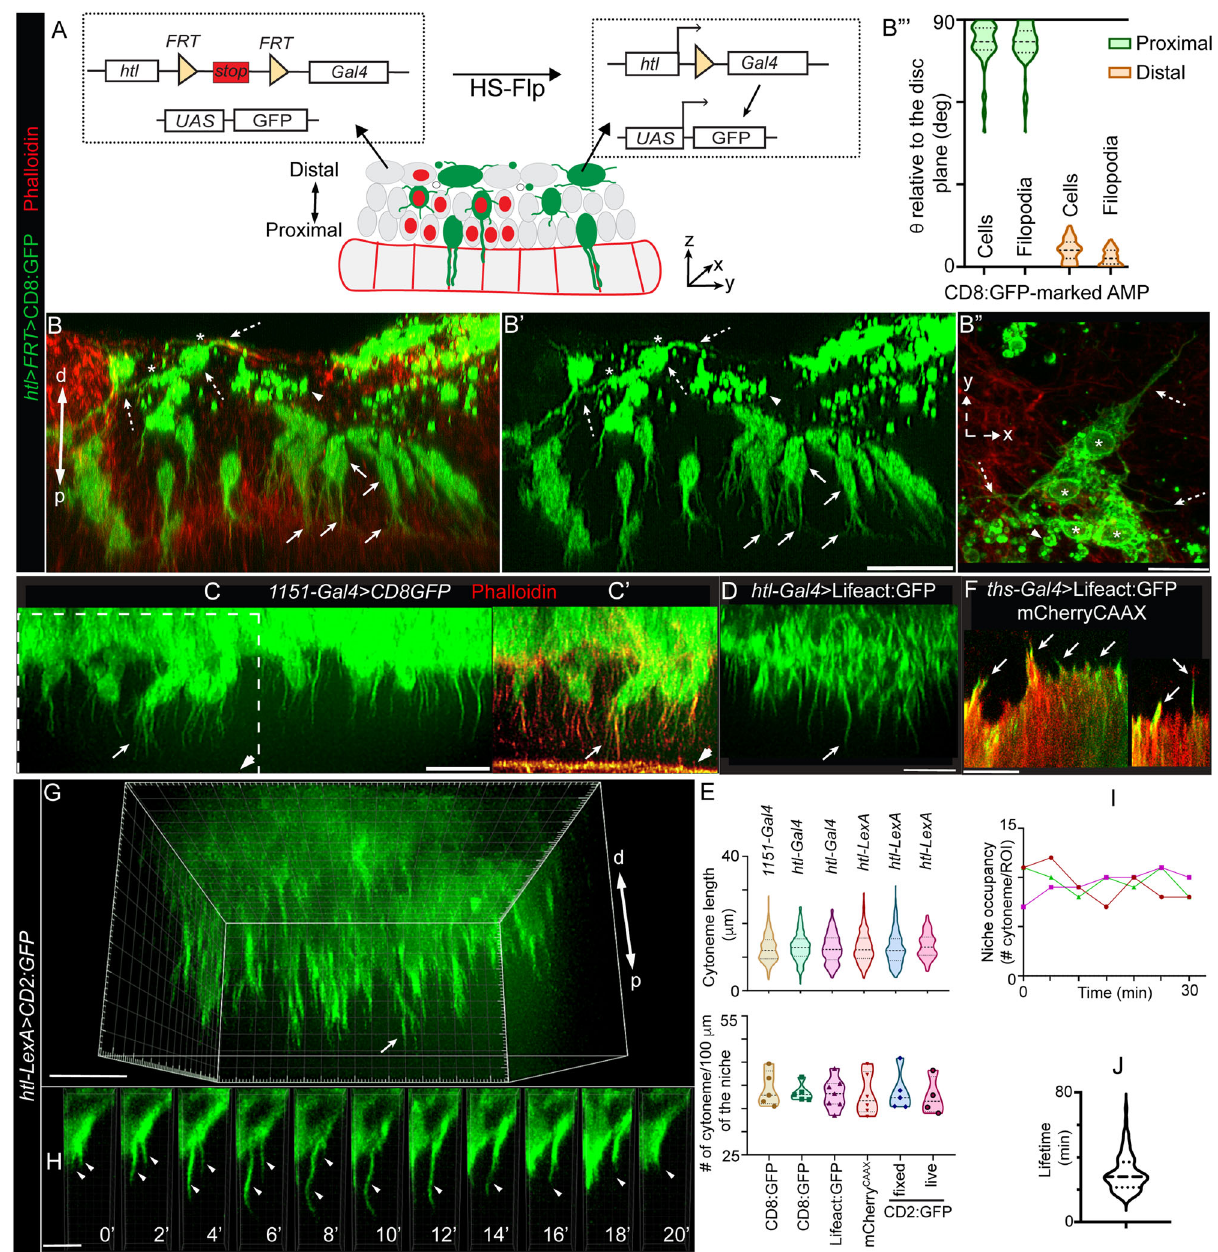
Fig. 2 Disc-speci fi c AMP polarity and adhesion are linked to polarized AMP cytonemes. A Schematic depiction of htl > FRT > stop > FRT > Gal4 construct and its application to generate FLIP-out clones exclusively in AMPs (also see Supplementary Fig. 1E, F). B - B ” Wing disc harboring random CD8:GFP-marked AMP clones ( hs-Flp; UAS-CD8:GFP; htl > FRT > stop > FRT > Gal4 ) showing orthogonal and lateral polarity of AMPs and AMP cytonemes relative to disc plane; arrow and dashed arrow, proximal and distal AMPs/AMP cytonemes, respectively; arrowhead, distal small non-polar cells; *, adherent distal AMPs; phalloidin (red), actin-rich disc-AMP junction and cell-cortex (also see Supplementary Fig. 1G – H ” ); B ’ GFP channel of B ; B ”’ Violin plots showing angles (Theta, θ ; see Fig. 1G) between proximal and distal AMPs and their cytonemes relative to their underlying disc plane (see Supplementary Table 2 for statistical analyses). C – E Comparison of AMP cytonemes (arrows) marked by various fl uorescent proteins driven by different transcription drivers, in fi xed and live tissues, as indicated; arrowhead, actin-rich (phalloidin-marked) apical-junction of disc epithelium; E Graphs comparing length and numbers (count/100 μ m length of AMP-disc interface) of orthogonal cytonemes ( n = >125 cytonemes for each genotype/condition, imaged from >5 wing disc/ genotype under fi xed condition and four discs under live condition; see “ Source Data ” for statistics). F Actin-rich cytonemes (arrow) from wing disc cells expressing mCherryCAAX and Lifeact:GFP ( fi xed tissue). G – J Live dynamics of AMP cytonemes; G 3D-rendered image showing live cytonemes captured from p-to-d direction of the tissue; H dynamics of cytonemes (arrow) (2 min time-lapse, also see Supplementary Movies 1 – 4); I Graphs showing numbers of niche-occupying cytonemes over time within selected ROIs; three graph colors, three discs; J Graph showing the distribution of cytonemes lifetimes ( n = 77 cytonemes; also see Supplementary Fig. 2D). Source data for B ”‘ , I , and J are provided as a “ Source Data ” fi le. C – J Genetic crosses: enhancer - Gal4 /- LexA x UAS -/ LexO - fl uorescent protein (FP), as indicated. Scale bars: 20 μ m; 5 μ m ( H ).